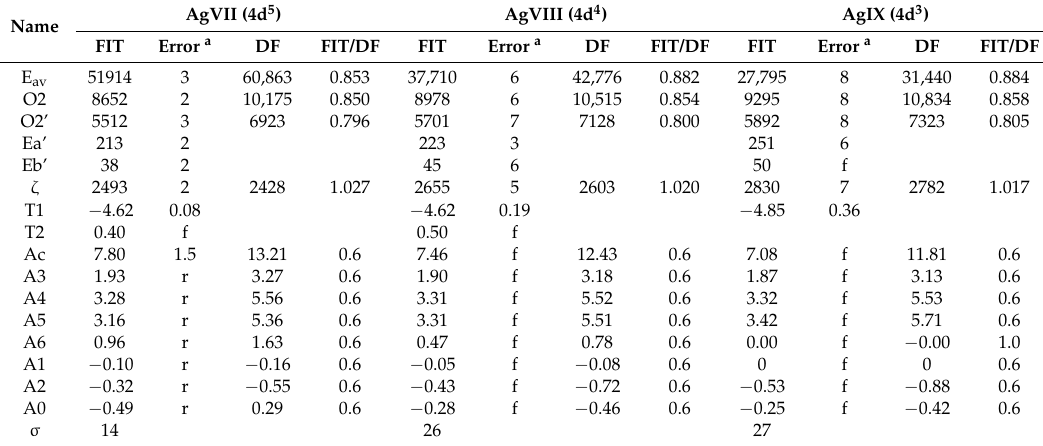
Table A12. Energy parameters (in cm − 1 ) of the ground configuration in Ag VII, Ag VIII and Ag IX calculated by orthogonal parameter technique in comparison with the Dirac-Fock (DF) parameters.